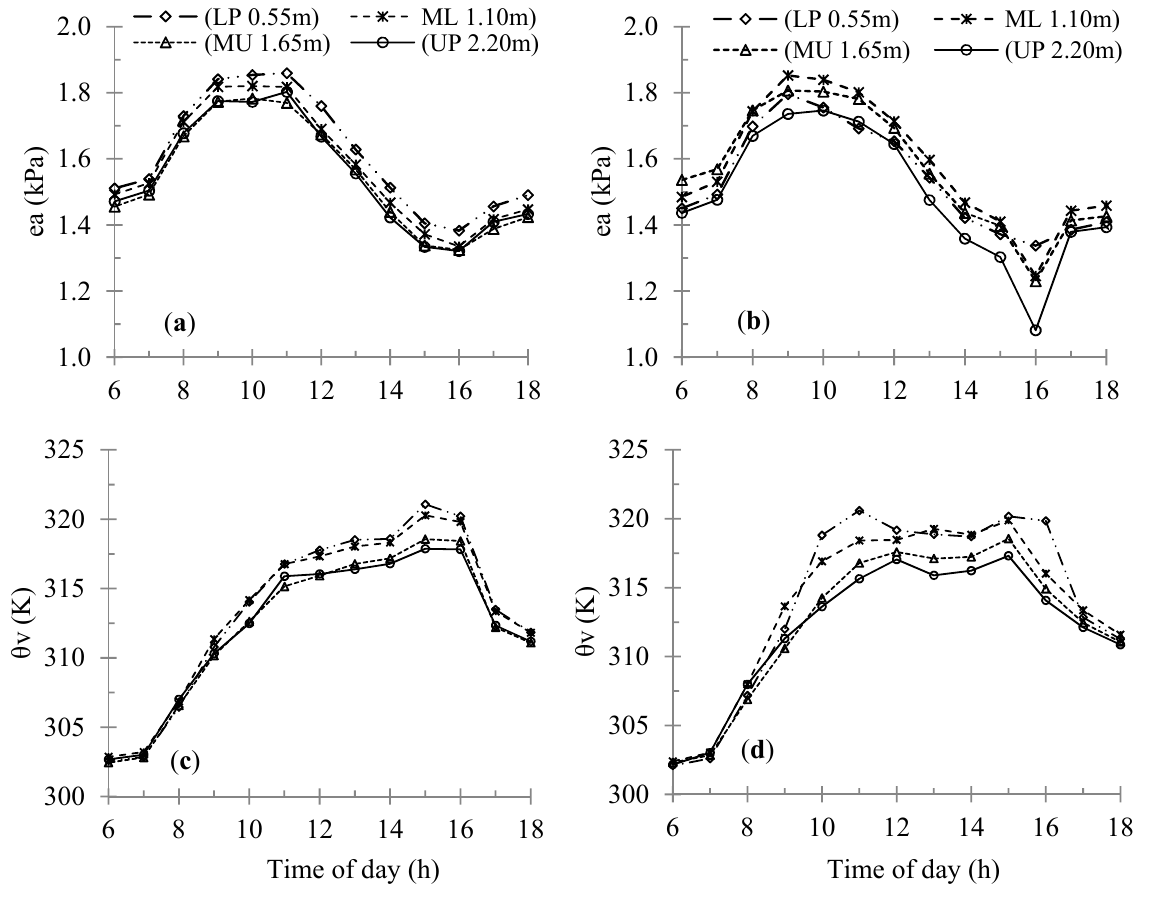
Figure 6. Diurnal trend of water vapor pressure ( ea ) and virtual potential temperatues ( (cid:2016) at four heights in the narrow and wide on 11 March 2009 (70 DAP), ( a ) Wide ( u